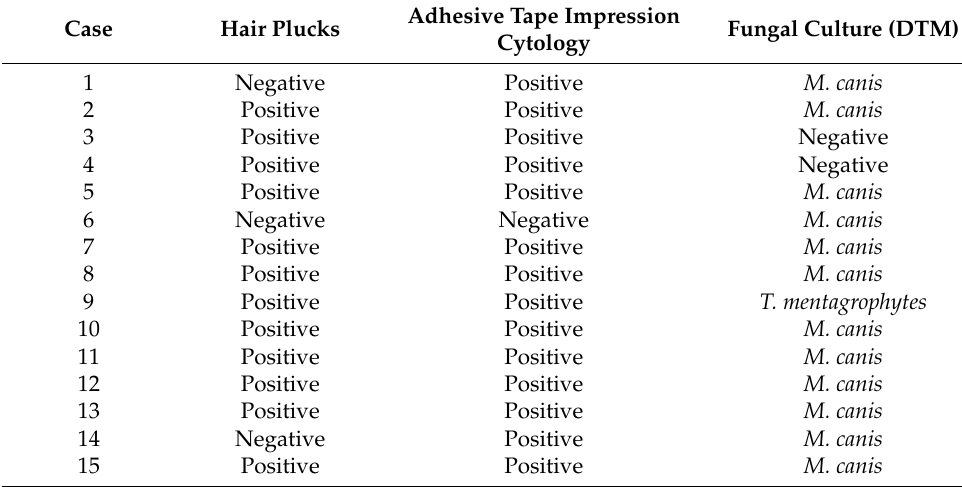
Table 5. Results of diagnostic tests in 15 cats with dermatophytosis.